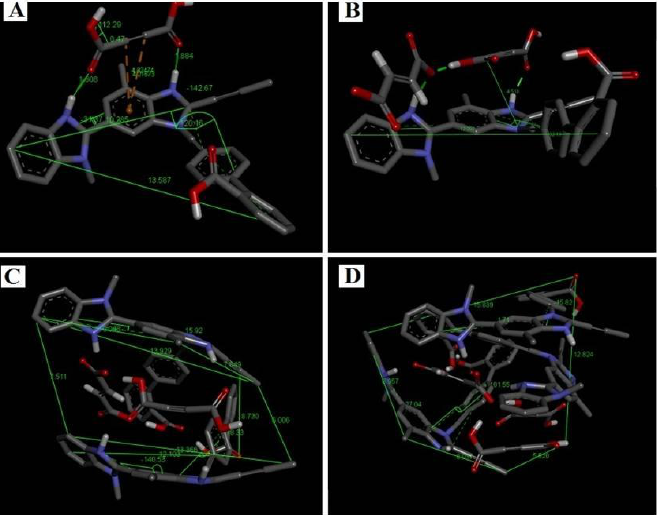
Figure 1. Spatial configuration of TEL-MAL-MALION complex. [(( A ). TEL:MAL:MALION = 1:1:0), (( B ). TEL:MAL:MALION = 1:1:1), (( C ). TEL:MAL:MALION = 2:1:1), (( D ). TEL:MAL:MALION = 3:1:1)].